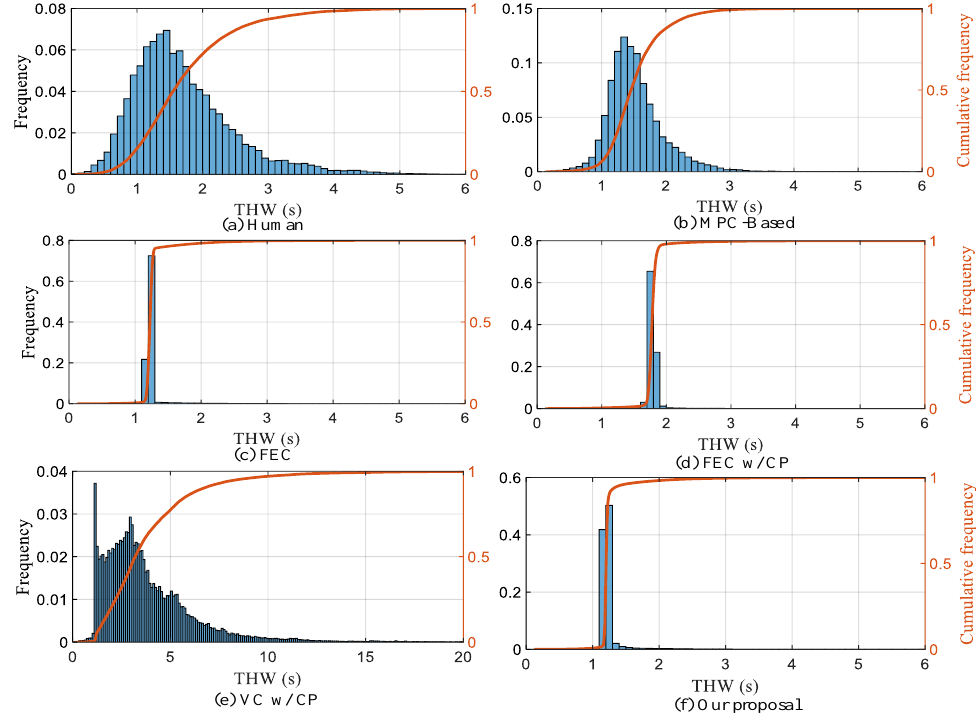
Figure 14. Comparison of THW frequency distribution for different strategies. Table 4. Ratio of efficiency for different strategies.